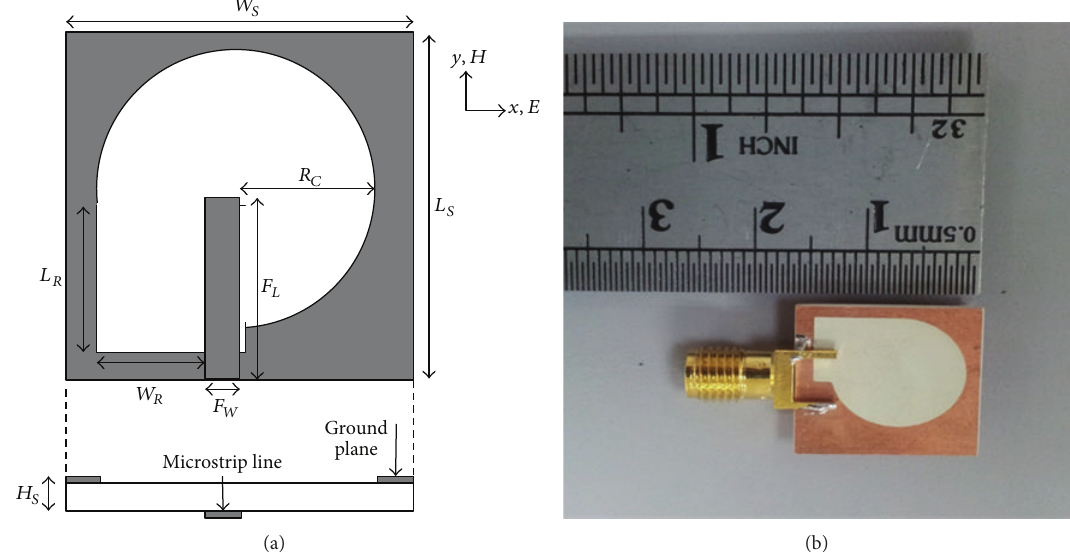
Figure 1: The proposed p-shaped wide-slot antenna. (a) The schematic and (b) the actual